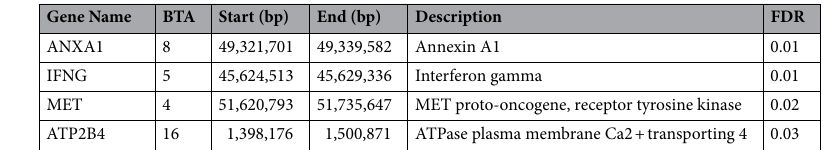
Table 4. Prioritized candidate genes relating to gametic incompatibility identified by guilt-by-association analysis in a list of 2075 Ensembl gene ID from genes positioned in transmission ratio distortion genomic regions associated with strong gametic interaction. BTA Bos taurus autosome, bp base pair, FDR false discovery